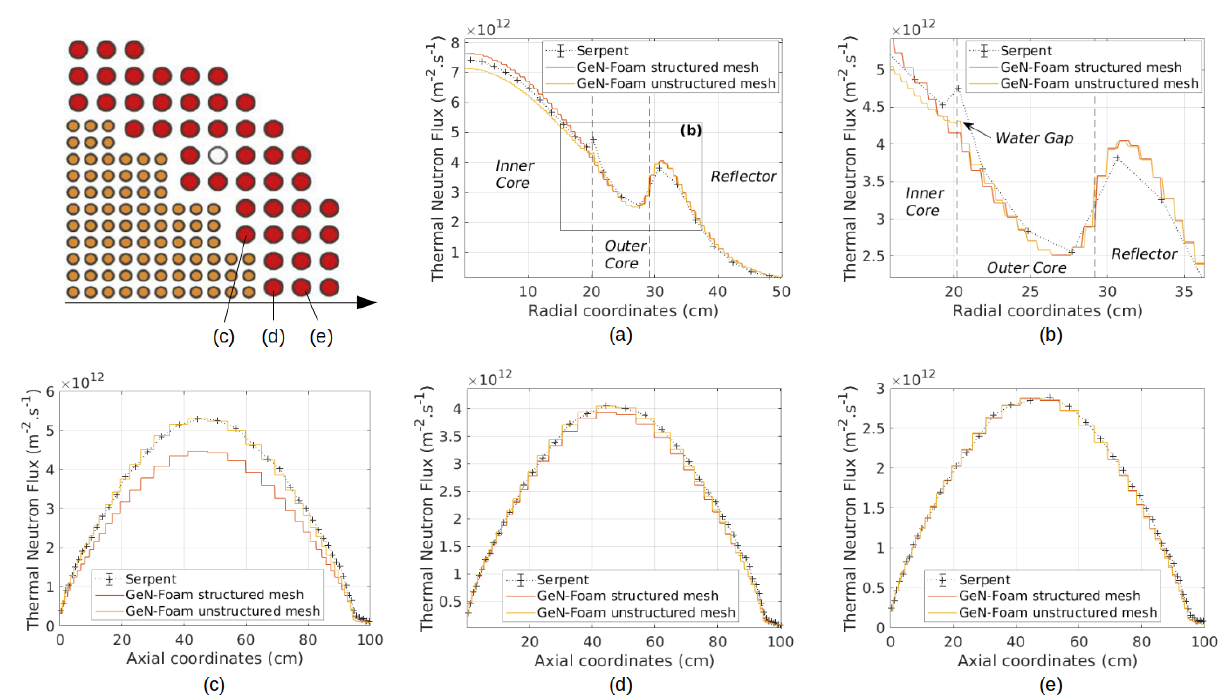
Figure 5. Comparison of both GeN-Foam models through thermal neutron flux profiles: ( a ) radial traverse from core center to the vessel (along the arrow on the upper-left scheme of CROCUS’ loading pattern) with ( b ) a zoom on the outer core region, and ( c – e ) axial traverses in three different outer core fuel rods. Serpent 2 predictions for each pin cell are also displayed as a